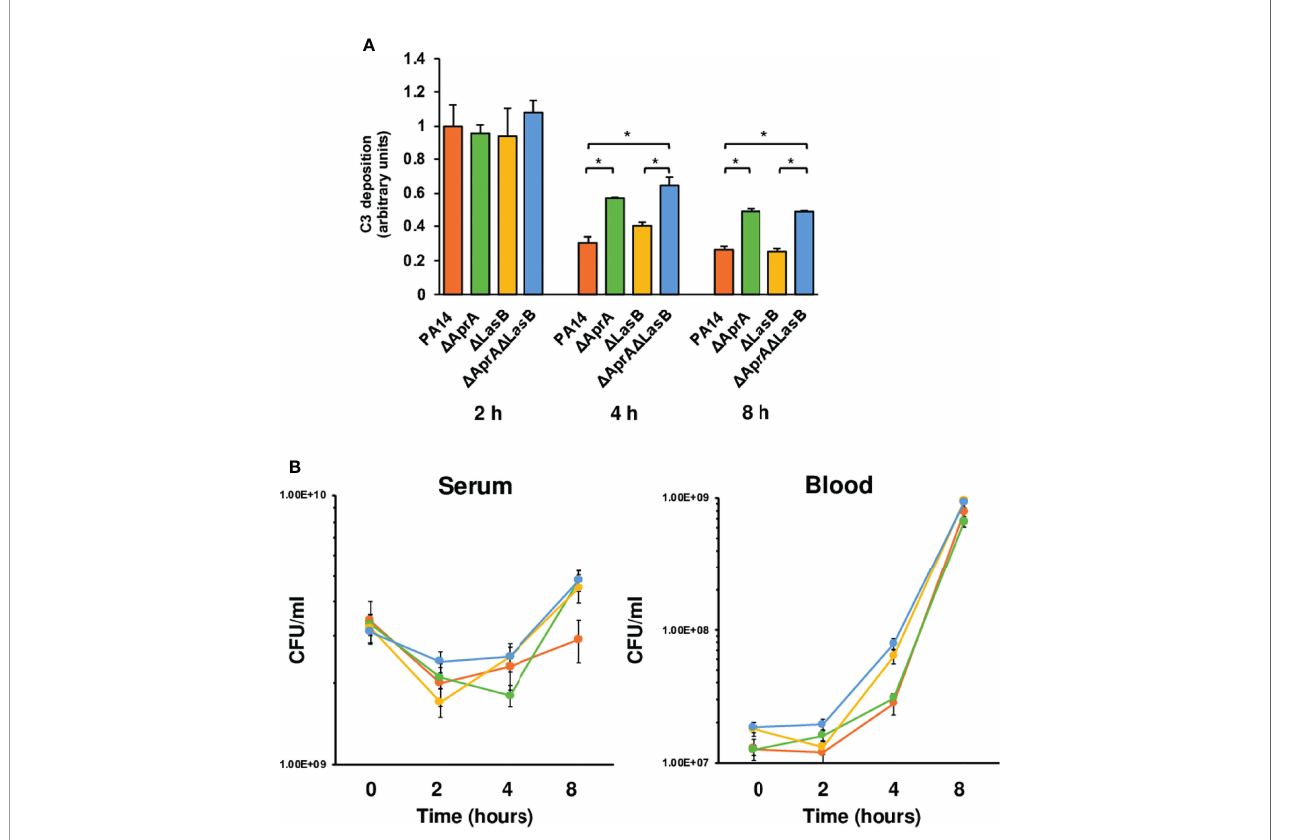
FIGURE 3 | Impact of AprA and LasB on the survival of P. aeruginosa in human serum or blood. (A) Analysis of complement component C3 deposition on P. aeruginosa . Wild-type strain PA14 or the isogenic mutants de fi cient in AprA, LasB or both were incubated in human serum and C3 deposited on the bacterial surface was determined by ELISA at different times. Control values in heat inactivated serum were always < 0.1 arbitrary units and were subtracted from the values obtained with human serum. Data represents three experiments done in duplicate. Errors bars represent SEMs. Statistical analyses were performed using ANOVA with post hoc Tukey; *P < 0.05. (B) Survival of P. aeruginosa strains in human serum or whole blood. P. aeruginosa WT strain PA14 (orange), or its derived isogenic mutants PA14 D aprA (green), PA14 D lasB (yellow) and PA14 D aprA D lasB (blue) were incubated in human serum or whole blood and quantitative bacterial cultures were performed at different times by plating on LB agar plates. Data represents three experiments done in duplicate. Errors bars represent SEMs. Statistical analyses were performed using